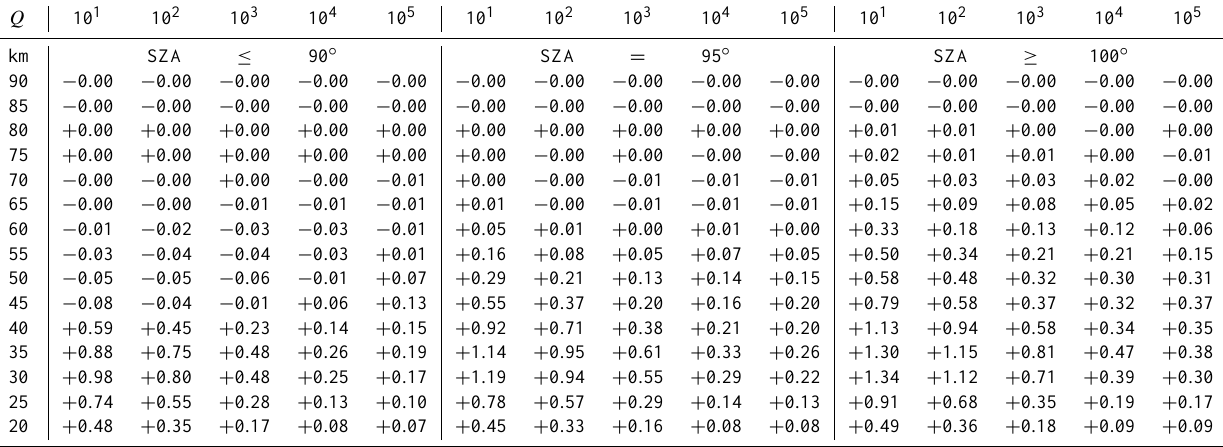
/Q for October NH. 3